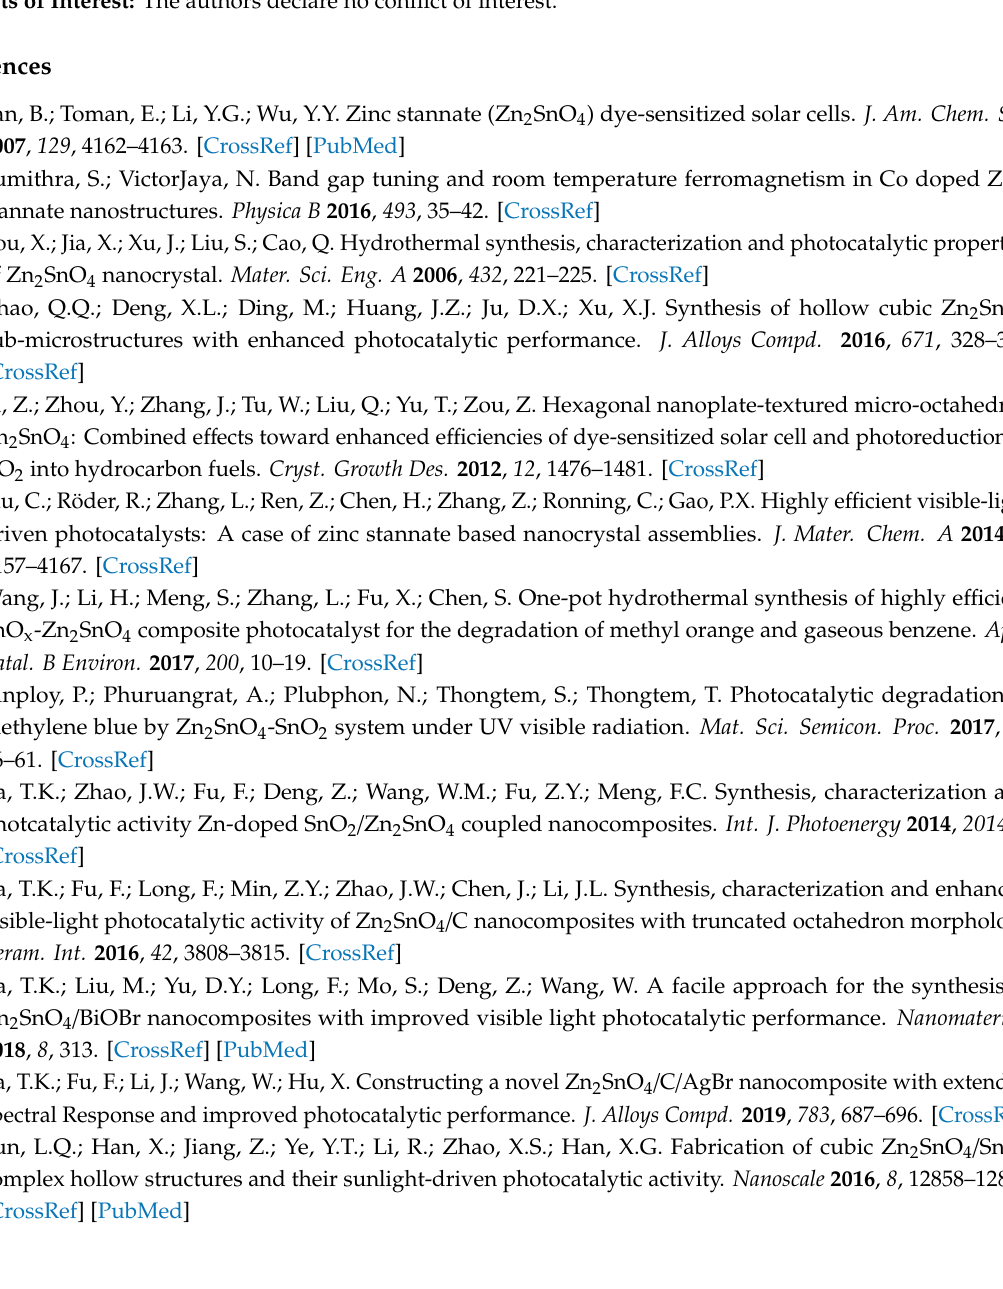
Figure S1: SEM image of Zn 2 SnO 4 / SnO 2 microspheres, Figure S2: Photocatalytic degradation curve of Zn 2 SnO 4 / SnO 2